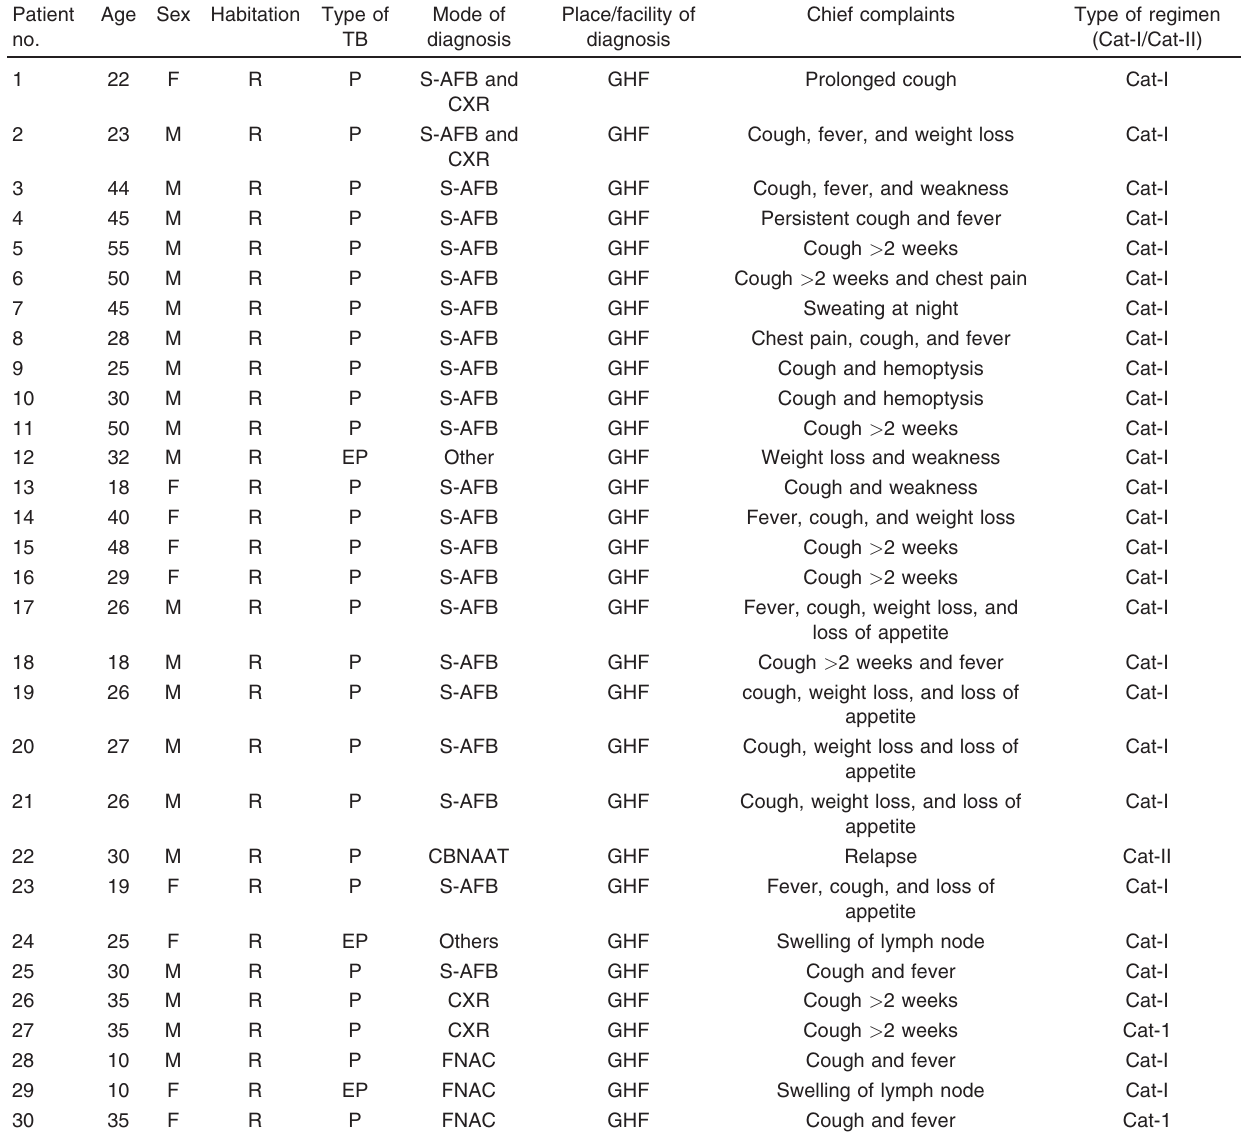
Table 1 Characteristics of the sample Patient Age Sex Habitation Type of no.